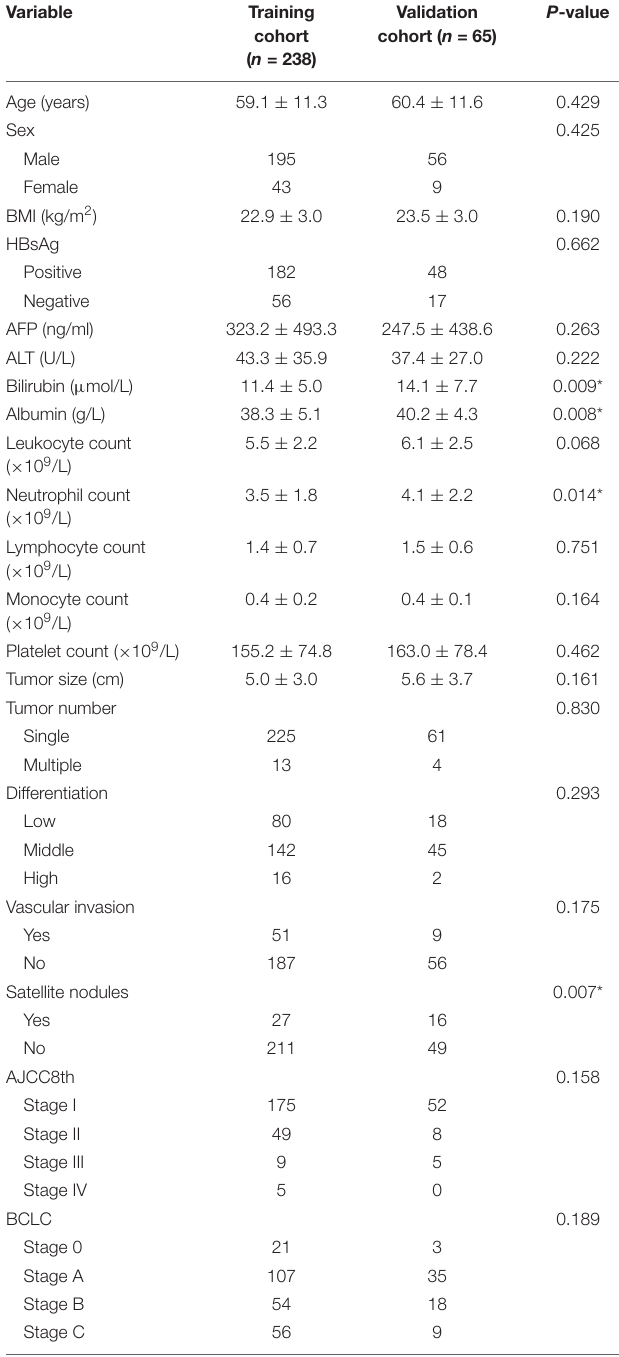
TABLE 1 | Demographic and clinical